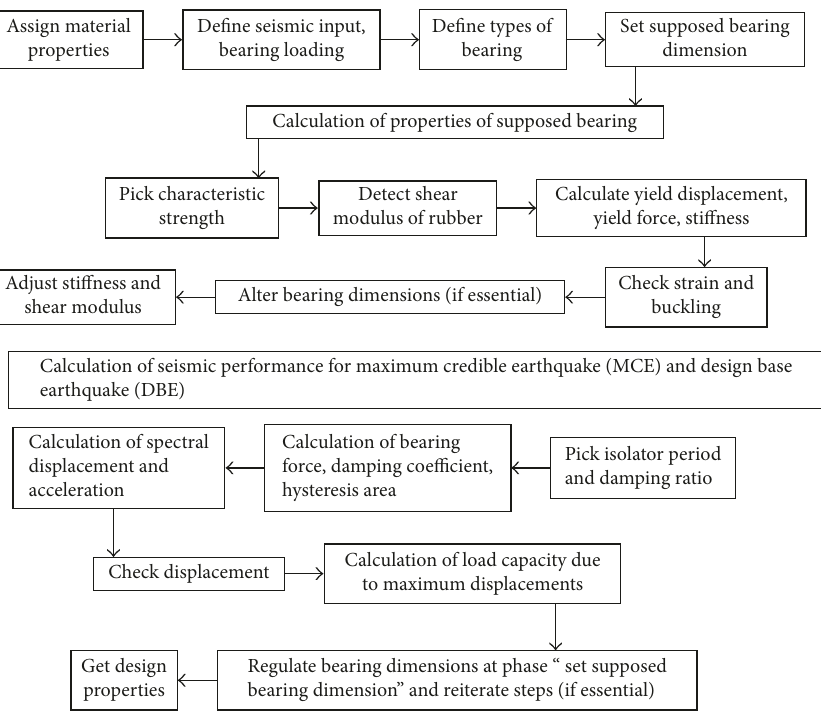
Figure 3: Typical design procedure of base